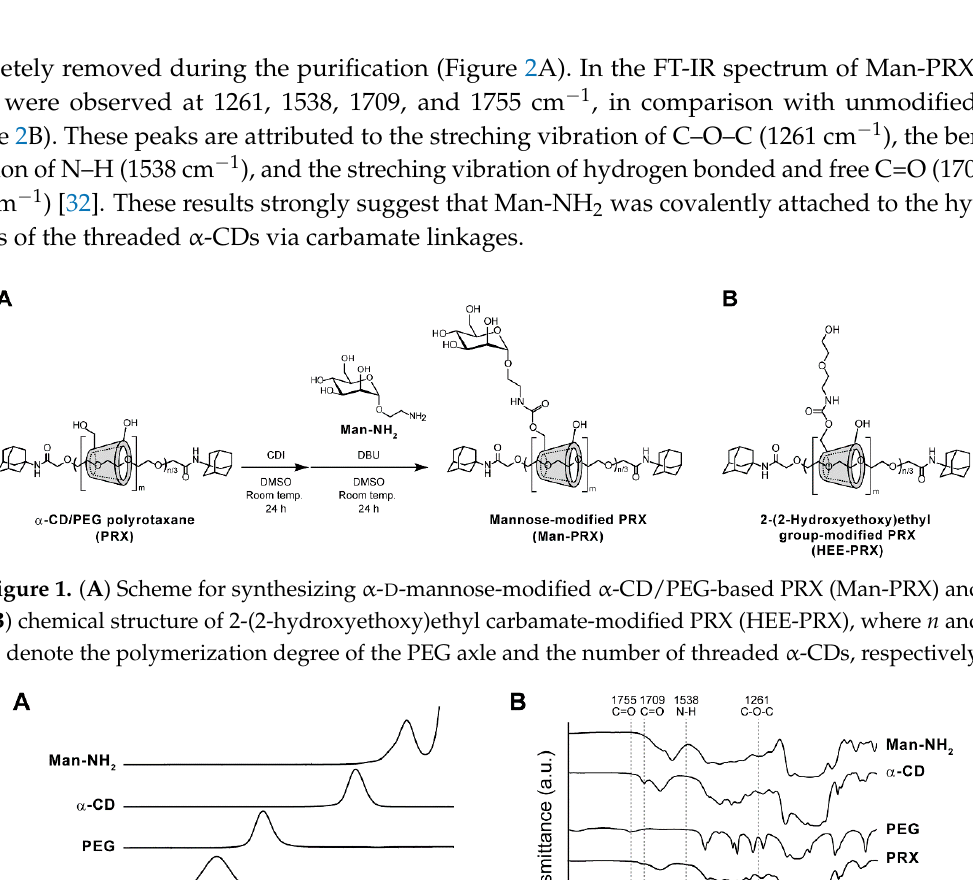
Figure 2. ( A ) SEC charts of Man-NH 2 , α -CD, axle PEG (biscarboxy-PEG, M n : 9,800), unmodified PRX, and Man-PRX in DMSO containing 10 mM LiBr at 60 °C. ( B ) FT-IR spectra of Man-NH 2 , α -CD, axle PEG, unmodified PRX, and Man-PRX.